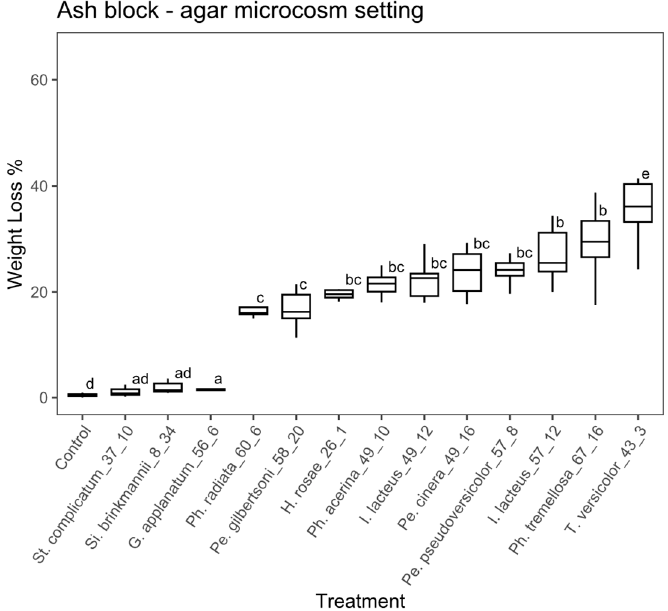
Figure 4. Boxplot of the percentage of weight loss for wooden blocks in the agar microcosm. Different letters represent statistical differences between treatments ( p < 0.01) .